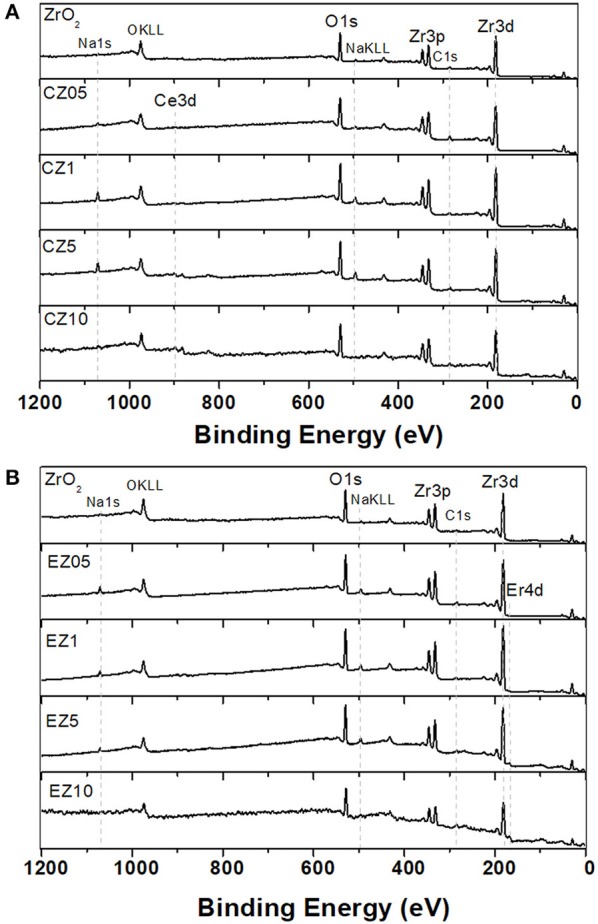
Wide-scan XPS spectra of pure ZrO2 and RE-doped ZrO2 [(A) RE = Ce, (B) RE = Er] with increasing concentration of RE dopant, as labeled in each spectrum.